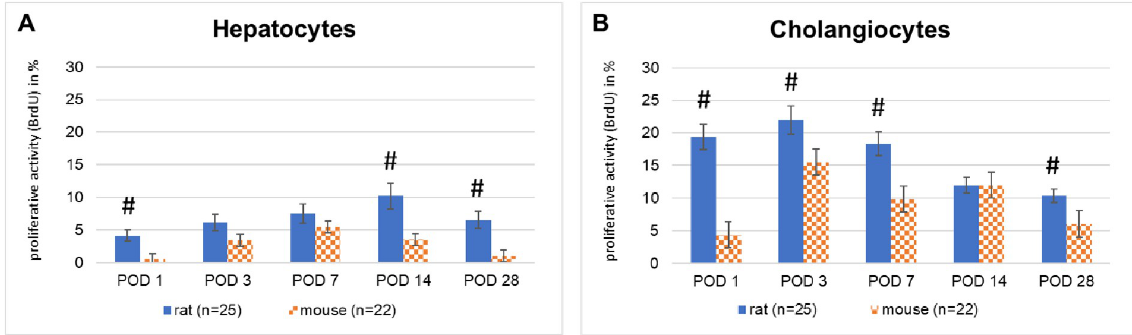
Fig 4. A, B: Proliferative activity of hepatocytes and cholangiocytes in rats and mice after total biliary occlusion.